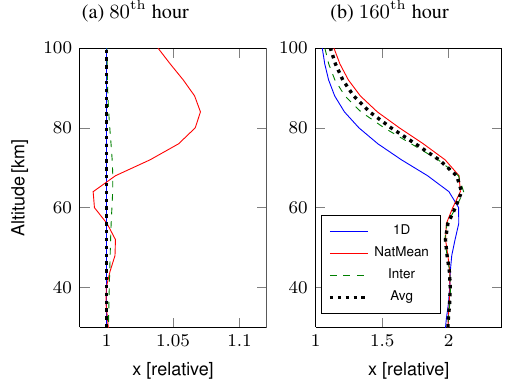
Fig. 3. Retrieved water vapour profiles (relative to the a priori) from Fig. 3: Retrieved water vapour profiles (relative to the a priori) from the simulated retrievals. The different curves represent the simulated retrievals. The different curves represent the single the single spectrum inversions (blue), the time series inversions using the NatMean (red line) and the intermediate covariance spectrum inversions (blue), the time series inversions using the Nat- matrix (dashed-green), and the inversions using the averaged spectra (black-dashed). Plot (a) is the retrieved profile at the 80 th Mean (red line) and the intermediate covariance matrix (dashed hour, when the true profile is equal to the a priori. Plot (b) is the retrieved profile at the 160 th hour, after the step-increase, green line), and the inversions using the averaged spectra (black when the true profile is double that of the a priori. dashed line). (a) is the retrieved profile at the 80th hour, when the true profile is equal to the a priori. (b) is the retrieved profile at the 160th hour, after the step-increase, when the true profile is double that of the a